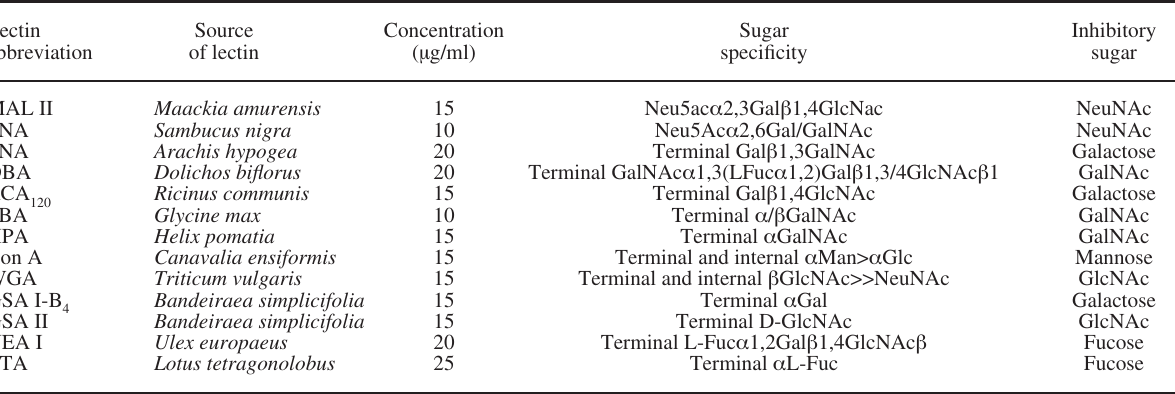
Table 1. – lectins used, their sugar specificities and the inhibitory sugars used in control experiments. Fuc, Fucose; Gal, galactose; Galnac, n-acetylgalactosamine; Glc, glucose; Glcnac, n-acetylglucosamine; Man, mannose; neunac, n-acetyl neuraminic (sialic) acid. lectin